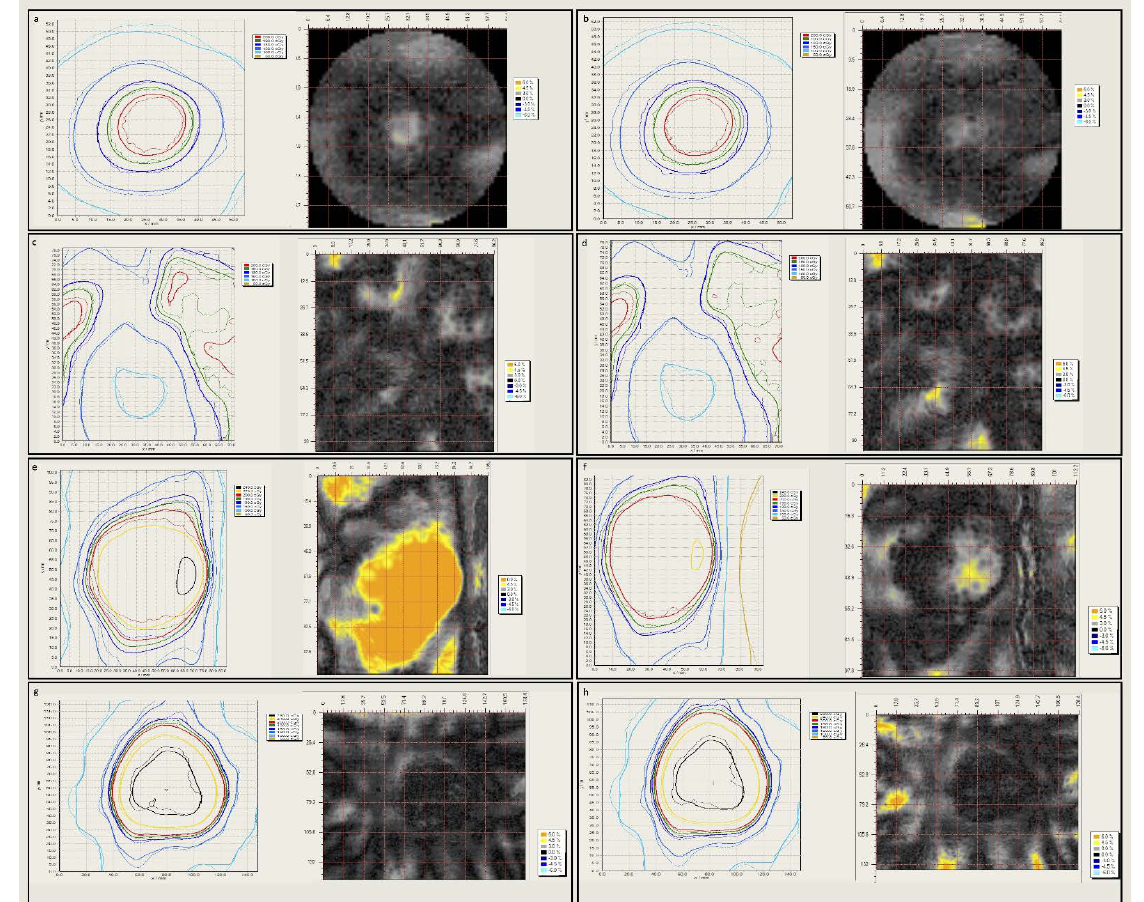
Figure 6. Isodose lines comparison (DC in bold and EBT3 in thin) and map of the gamma values (local, 3%/3 mm, threshold 10%) for the different considered treatment sites and calculation algorithms. ( a ) Brain plan and PB calculation algorithm; ( b ) Brain plan and CC calculation algorithm; ( c ) H&N plan and PB calculation algorithm; ( d ) H&N plan and CC calculation algorithm; ( e ) Lung plan and PB calculation algorithm; ( f ) Lung plan and CC calculation algorithm; ( g ) Prostate plan and PB calculation algorithm; ( h ) Prostate plan and CC calculation algorithm.